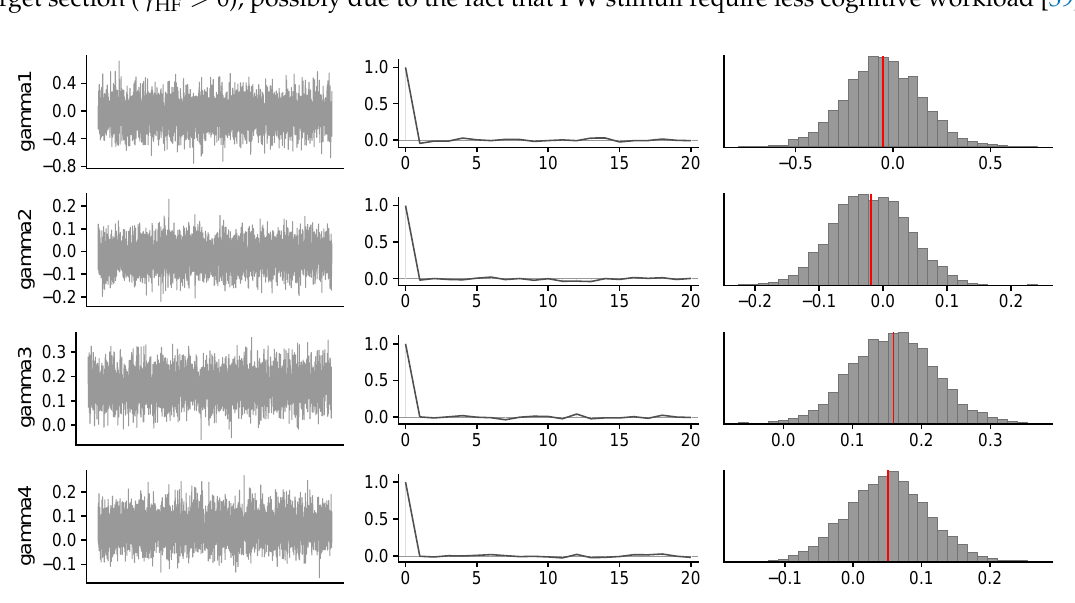
Figure 4. Illustrative example: MCMC traces, autocorrelation plots, and marginal posterior distributions for the model parameters. Note that all the Gelman-Rubin indices (Rhat) of the parameters are 1.0. Table 2. Illustrative example: Posterior quantities and Gelman-Rubin indices (Rhat) for the model